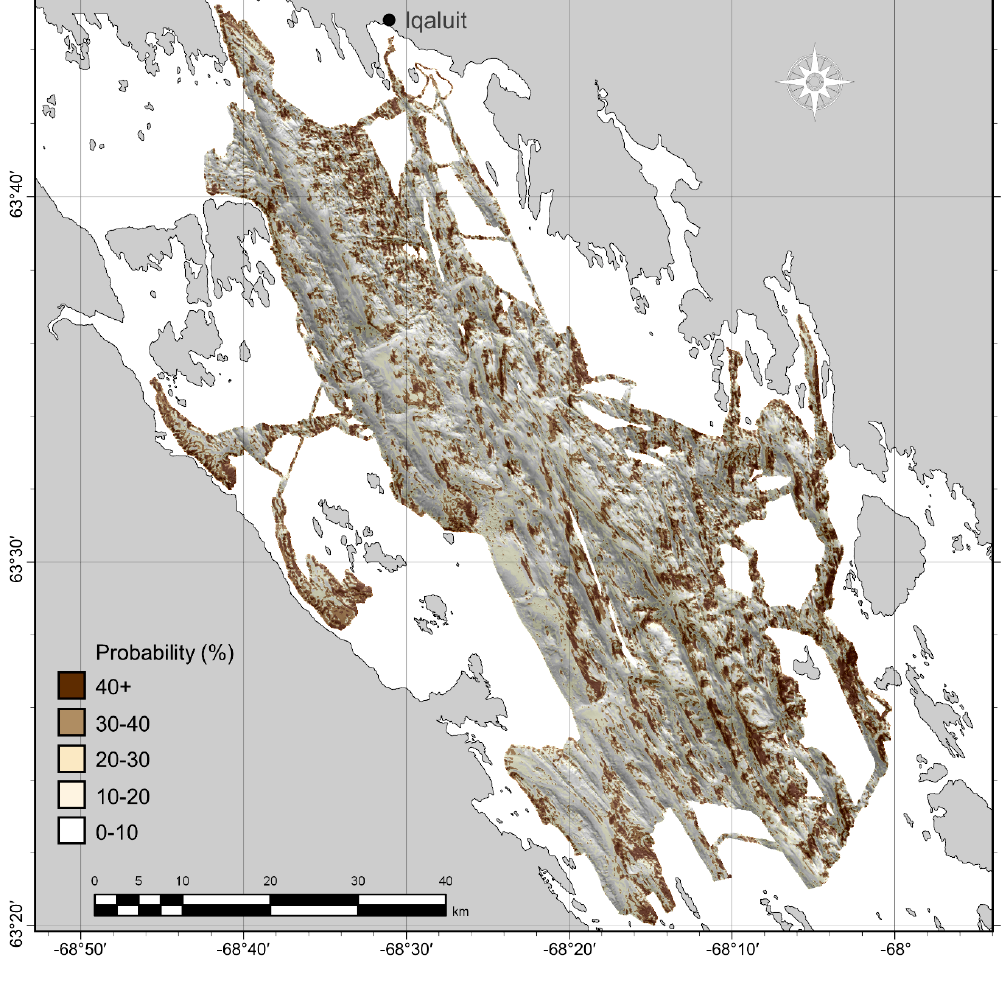
Figure 11. Predicted probability of coarse substrates using the spatially resampled leave-one-out cross validation (SR-LOO CV) (200 m) model.